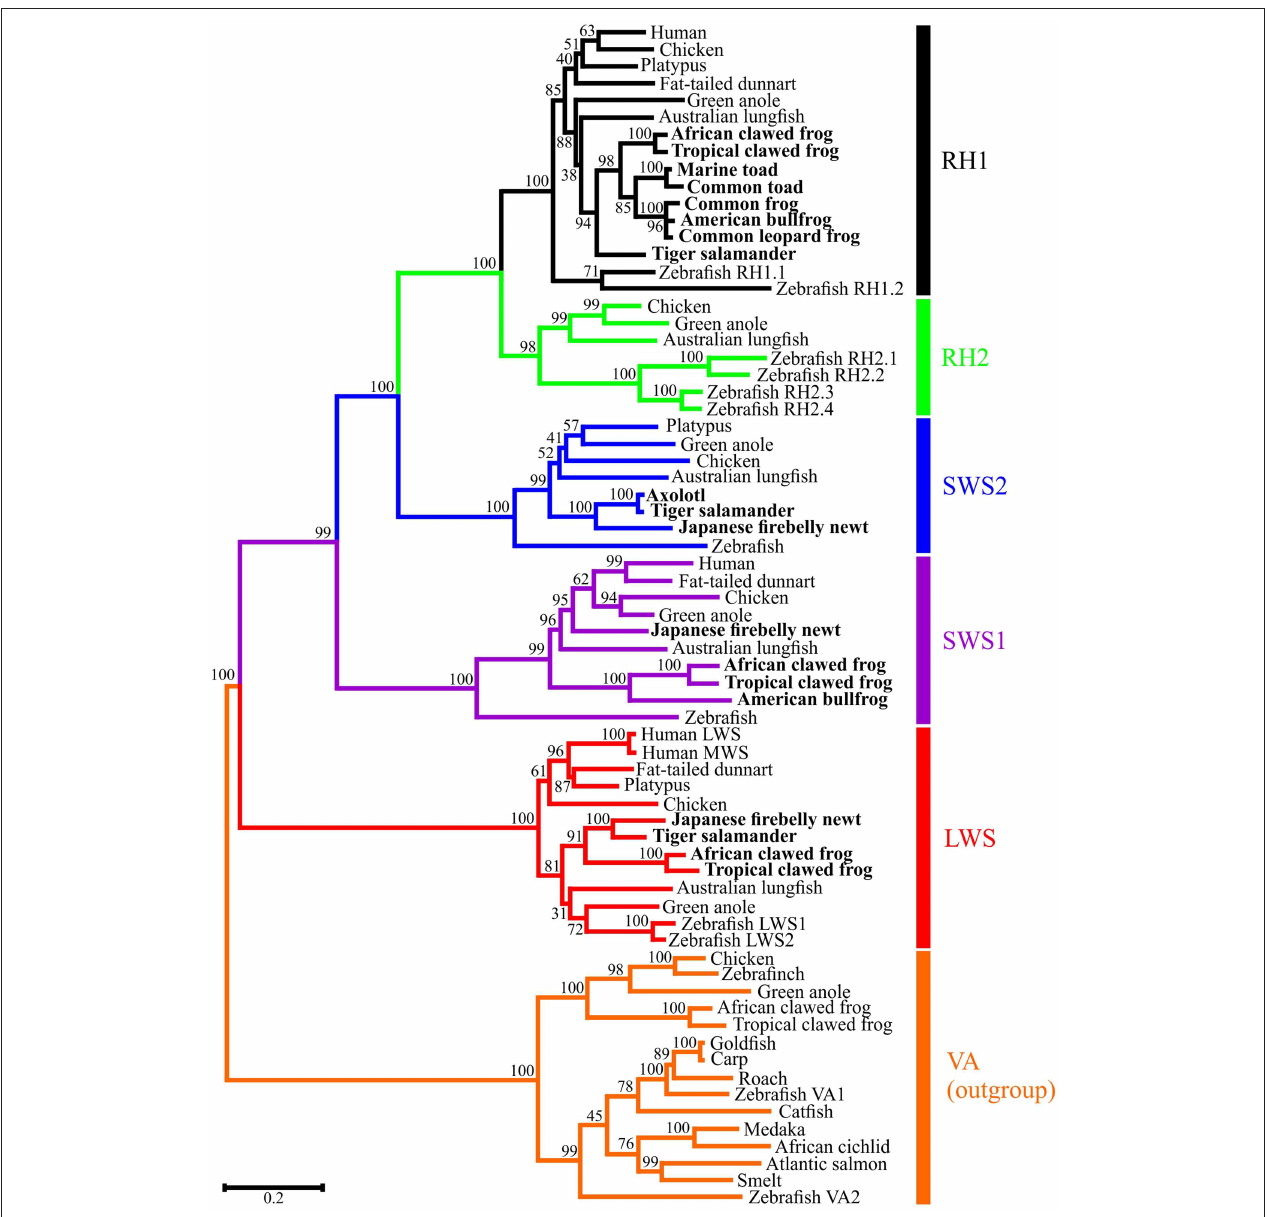
FIGURE 2 | Molecular phylogenetic analysis by Maximum Likelihood (ML) method. The evolutionary history was inferred by using the ML method based on the General Time Reversible (GTR) model (Nei and Kumar, 2000). The tree with the highest log likelihood (-35193.70) is shown. The percentage of trees in which the associated taxa clustered together is shown next to the branches. Initial trees for the heuristic search were obtained automatically by applying Neighbor-Join and BioNJ algorithms to a matrix of pairwise distances estimated using the Maximum Composite Likelihood (MCL) approach, and then selecting the topology with superior log likelihood value. A discrete Gamma distribution was used to model evolutionary rate differences among sites [5 categories ( + G, parameter = 0.9332)]. The rate variation model allowed for some sites to be evolutionarily invariable ([ + I], 11.19% sites). The tree is drawn to scale, with branch lengths measured in the number of substitutions per site. The analysis involved 69 nucleotide sequences. Codon positions included were 1st + 2nd + 3rd + Noncoding. All positions with less than 95% site coverage were eliminated. That is, fewer than 5% alignment gaps, missing data, and ambiguous bases were allowed at any position. There were a total of 942 positions in the final dataset. Evolutionary analyses were conducted in MEGA7 (Kumar et al., 2016).